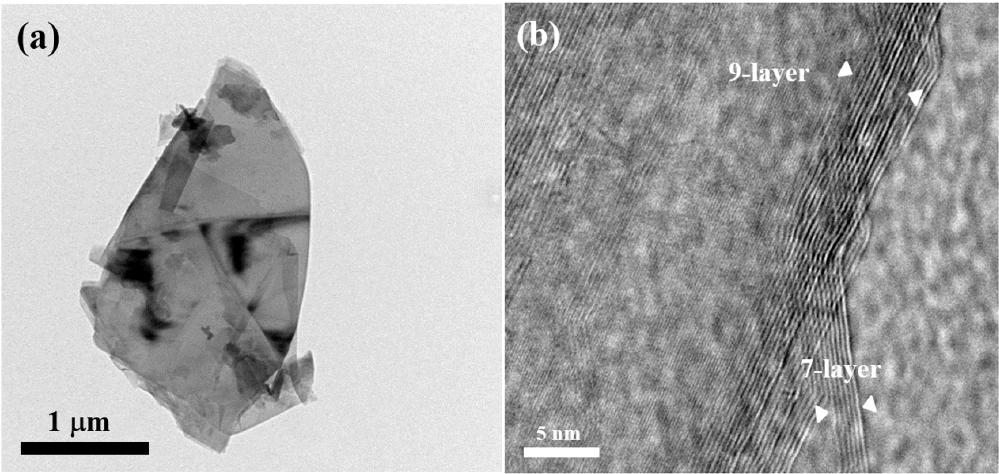
Figure 5. ( a ) Transmission electron microscopy (TEM) image of FLG20 and ( b ) high-resolution transmission electron microscopy (HRTEM) image of FLG20. transmission electron microscopy (HRTEM) image of